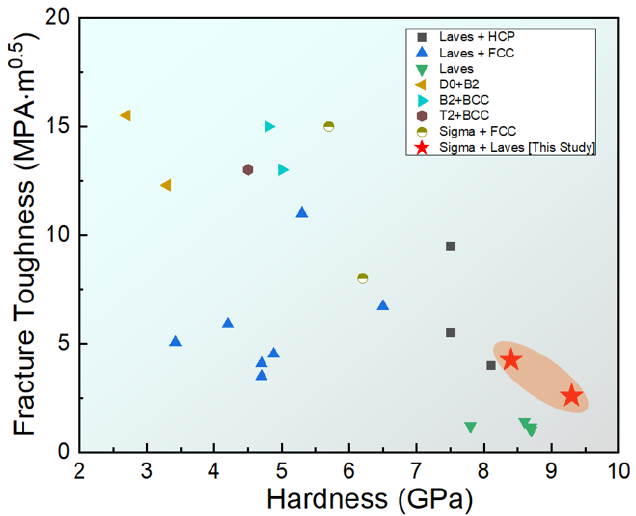
Figure 7. Comparison of the room temperature fracture toughness K versus hardness H between our alloys and other intermetallic-phase containing alloys. Note that the prior data come from Refs. [20,34–41] .